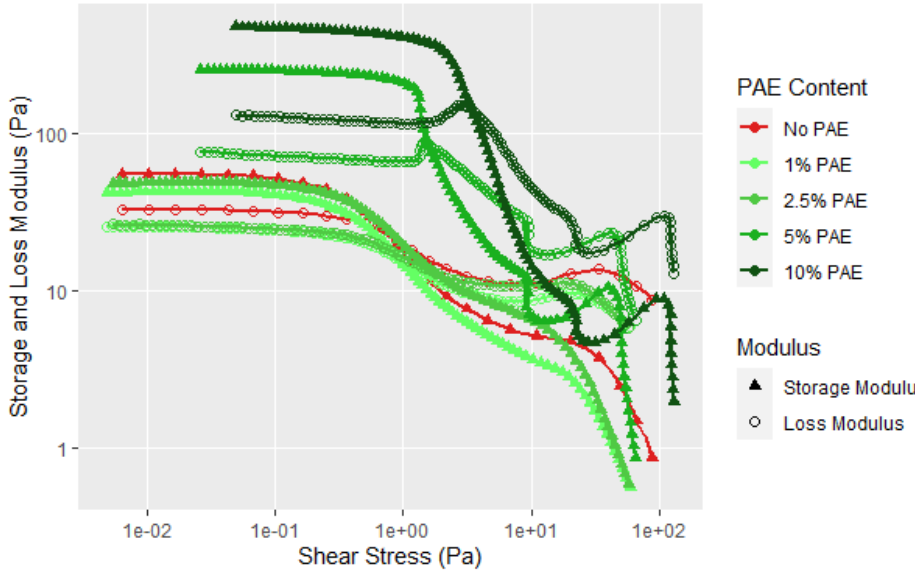
Figure 12. Shear rheology with increasing amplitude for soy flour (90 PDI at 25% solids) without and with the addition of PAE at solids levels relative to soy solids.